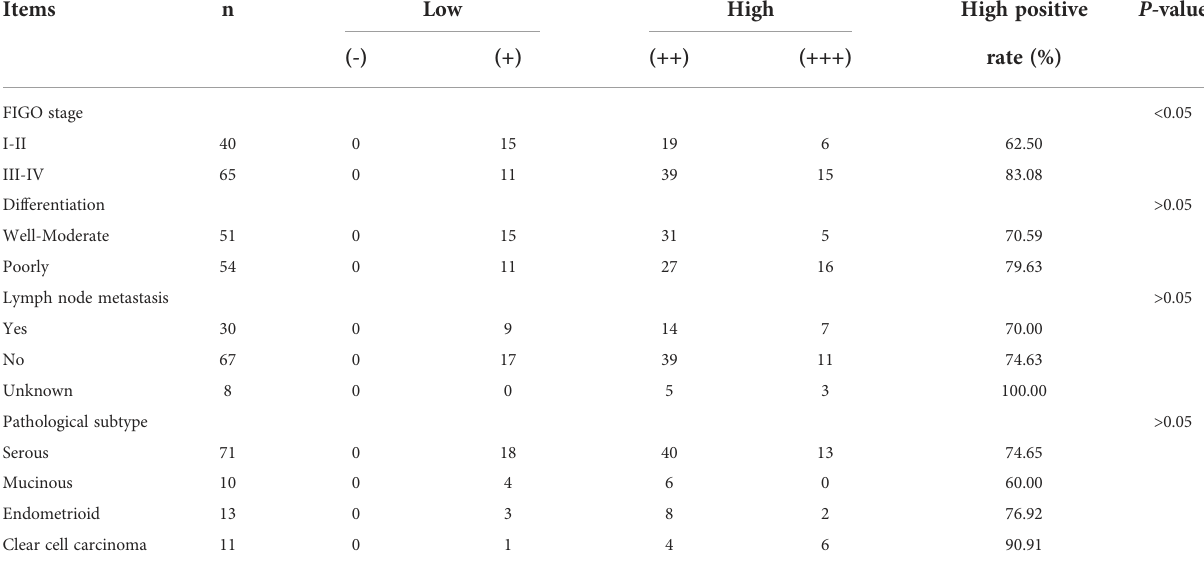
TABLE 2 Relationship between MCP-4 expression and clinicopathological parameters of ovarian epithelial malignant tumors. Items